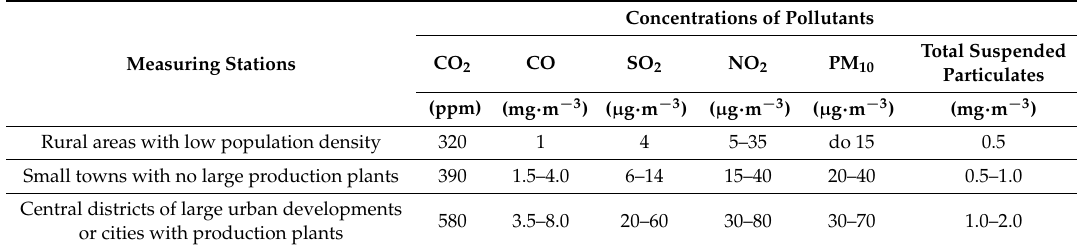
Table 2. Sample average concentrations of pollutants in outdoor